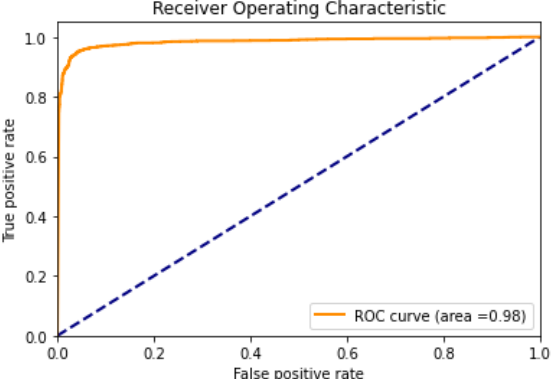
Figure 9. Receiver Operating Characteristic (ROC) curve of the model training result.